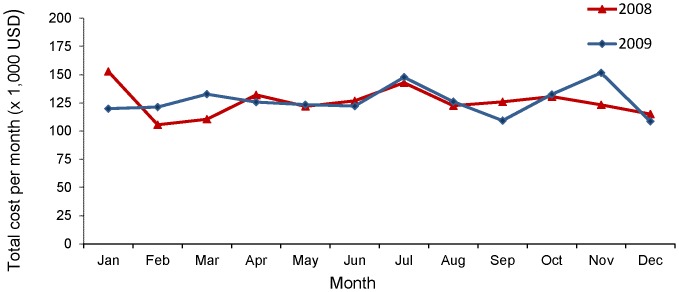
Distribution of total monthly expenditure on dry eye treatment in 2008 and 2009.